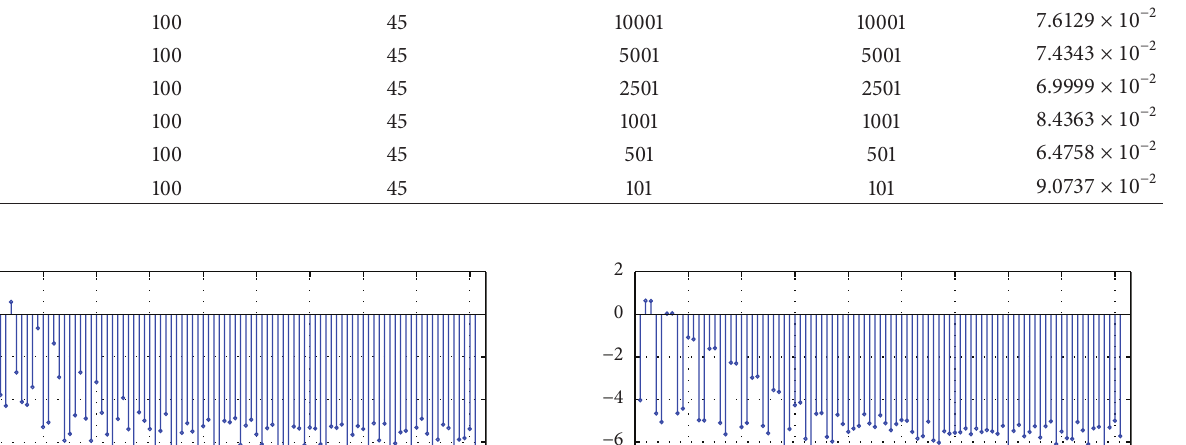
Table 15: Relation between the error E and the number of sections 𝑆 and samples per section 𝐶 , when 𝜎 = 2 + sin 5(𝑥 + 𝑦) . Number of Points per radii 𝑅